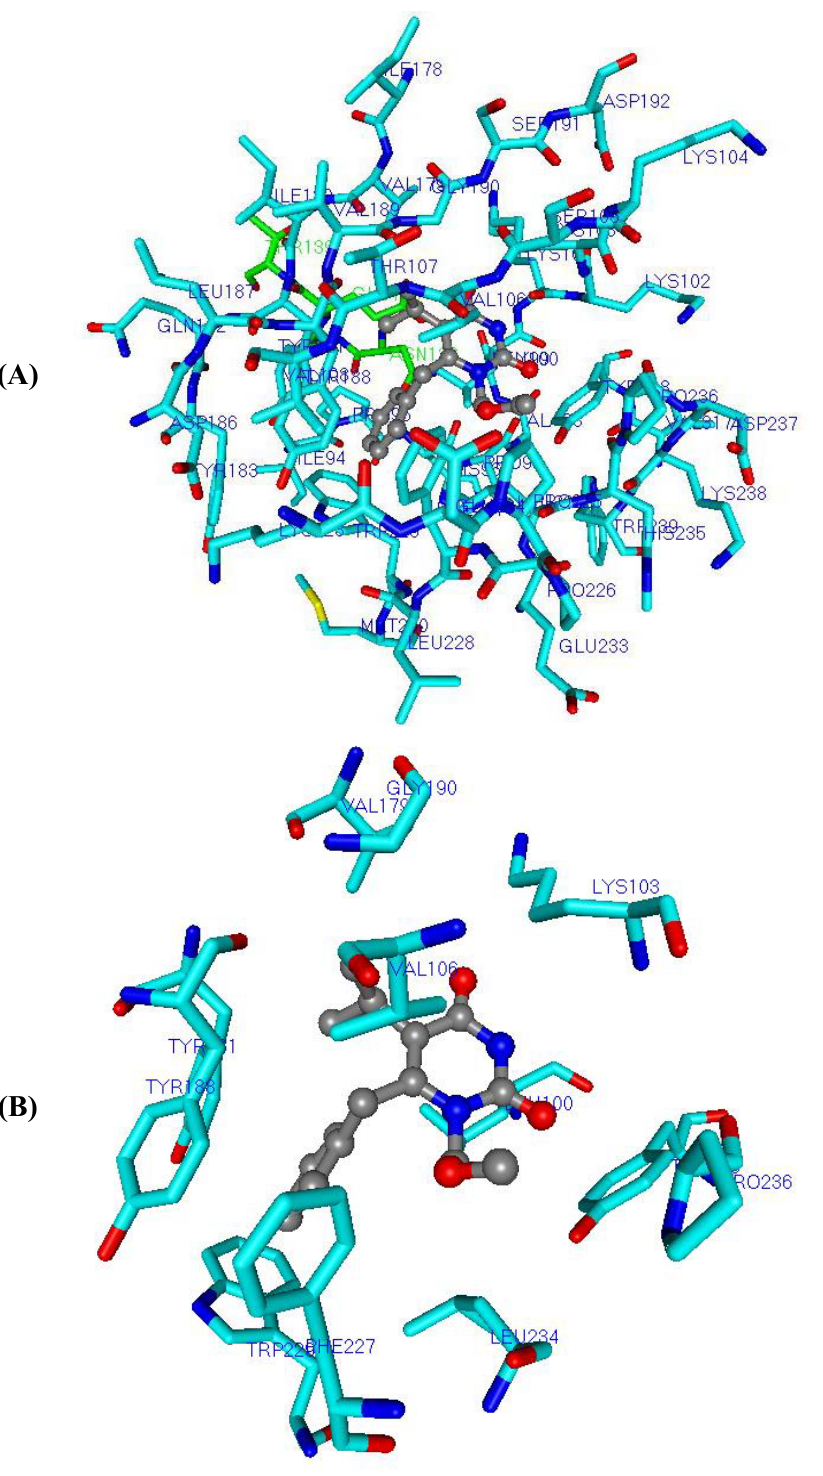
Figure 4. ( A ) Reduced model complex of the RT of HIV-1 (stick model, carbon atoms of the p66 subunit in light blue and p51 in green) showing all 53 residues included in the radius of 10 Å from the inhibitor MKC-442 (ball-and-stick model, carbon atoms in gray). ( B ) Close view of the reduced model complex, showing only the residues included in the radius of 5